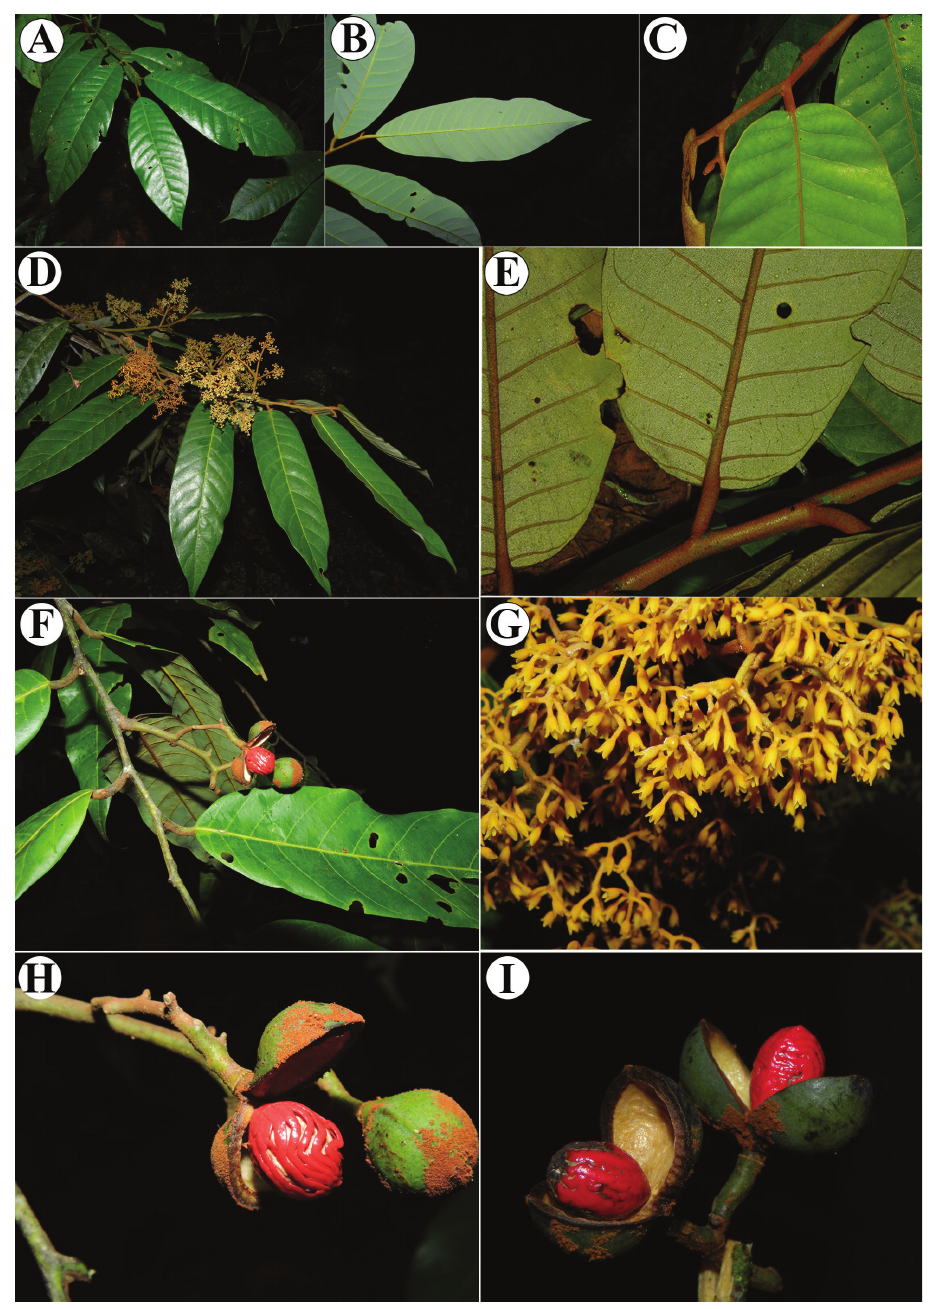
Figure 28. Virola sebifera A leaf blade on adaxial surface B leaf blade on abaxial surface C, E leaf base on both sides D flowering branch G staminate flowers H infructescence I fruits and aril. Photos by Reinaldo